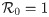
Functional dependence of the basic reproduction number from the detection rates ηA, ηS and the transmission rate of the diagnosed compartment γ.Black surface: R0=1; Orange surface: γ = 0.01, Blue surface: γ = 0.05, Green surface: γ = 0.09, Red surface: γ = 0.3. All the remaining parameters are fixed to their value at t = 0.